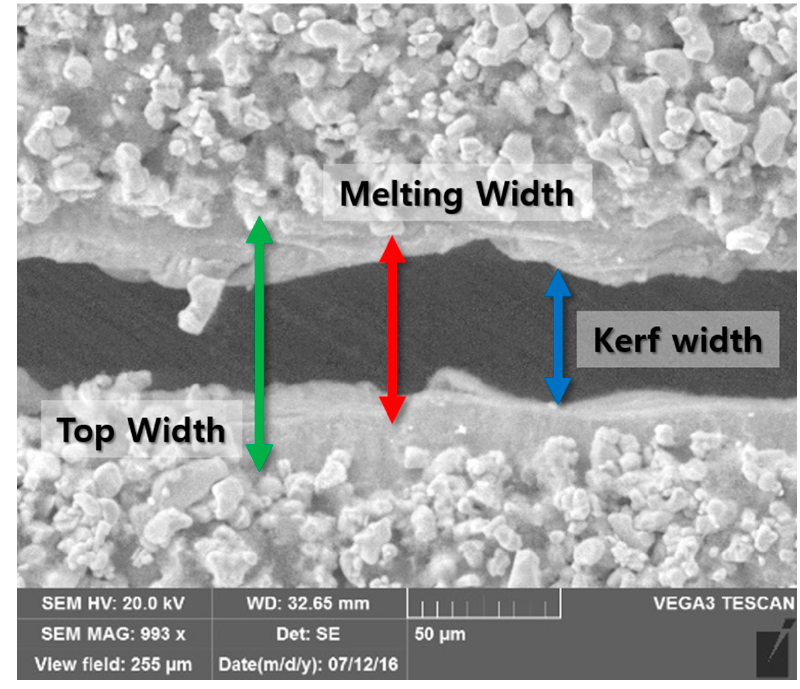
Figure 2. Definition of measured width.